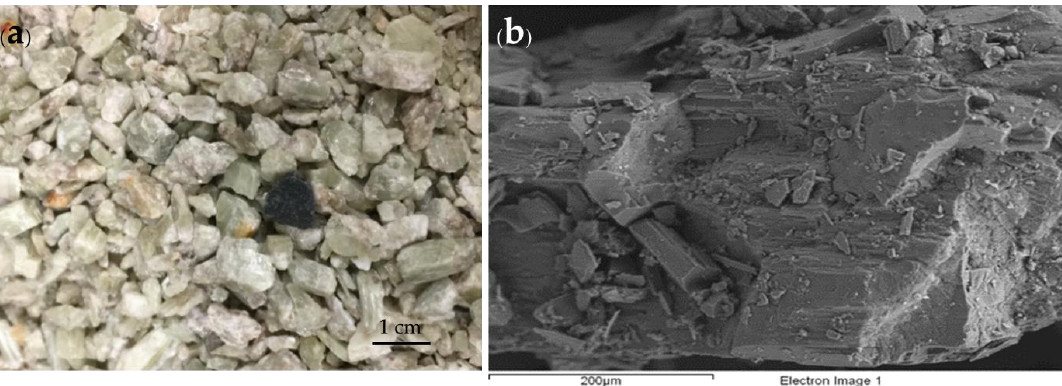
Figure 5. ( a ) Macroscopic (Optical), ( b ) Microscopic (SEM) aspects of a typical α-spodumene sample .